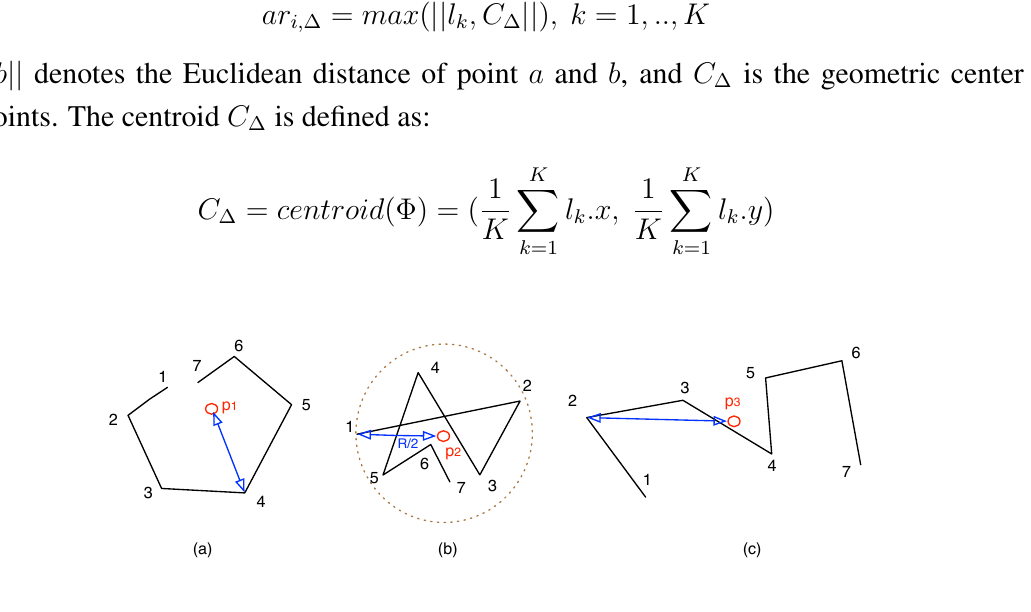
; ( c ) moving trajectories of node s 2